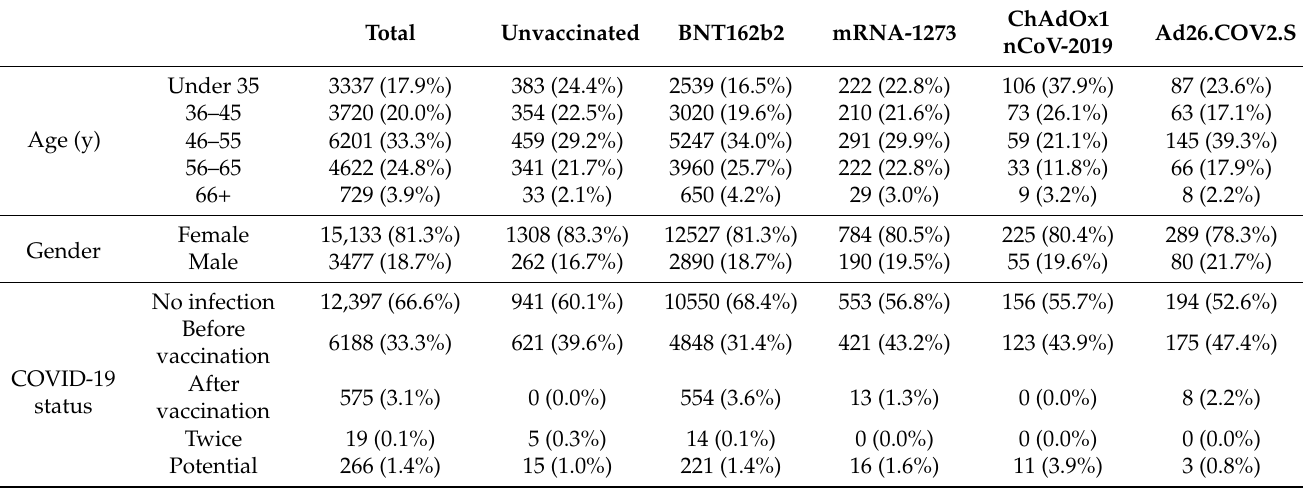
Table 1. Characteristics of the study